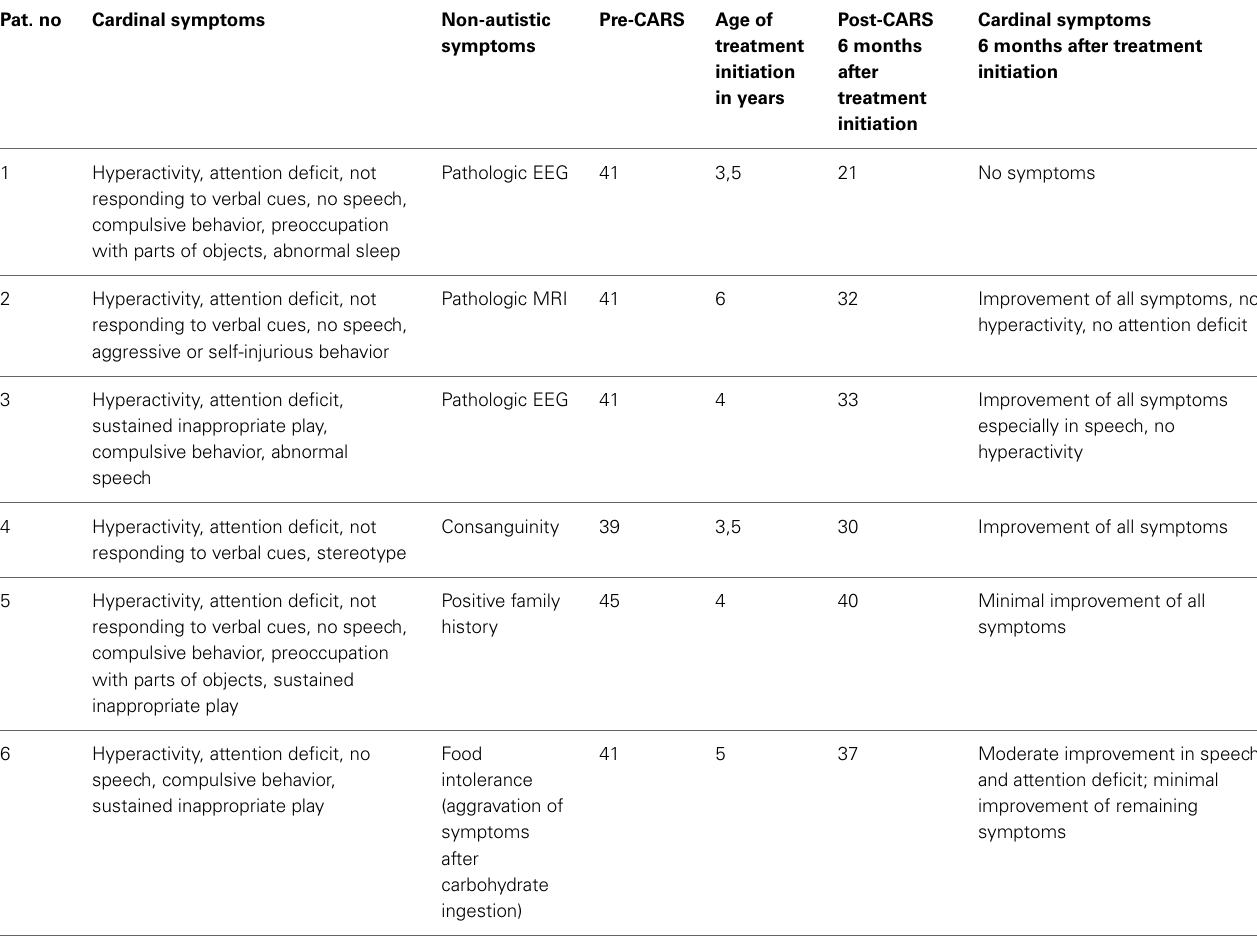
Table 4 | ASD patients responsive to ketogenic diet implementation. Pat. no